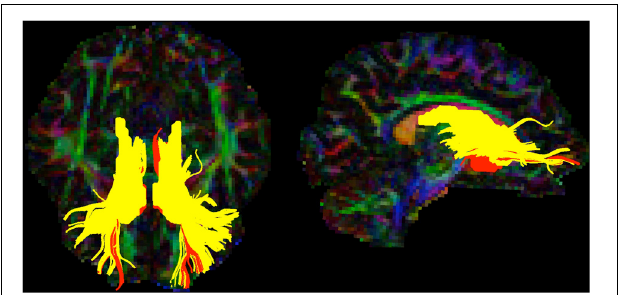
FIGURE 4 | Caudate and NAcc tracts for the template subject. Tracts are shown in the axial (left) and sagittal (right) planes in neurological convention (left is left). The caudate-prefrontal tracts are shown in yellow and NAcc-prefrontal tracts are shown in red.